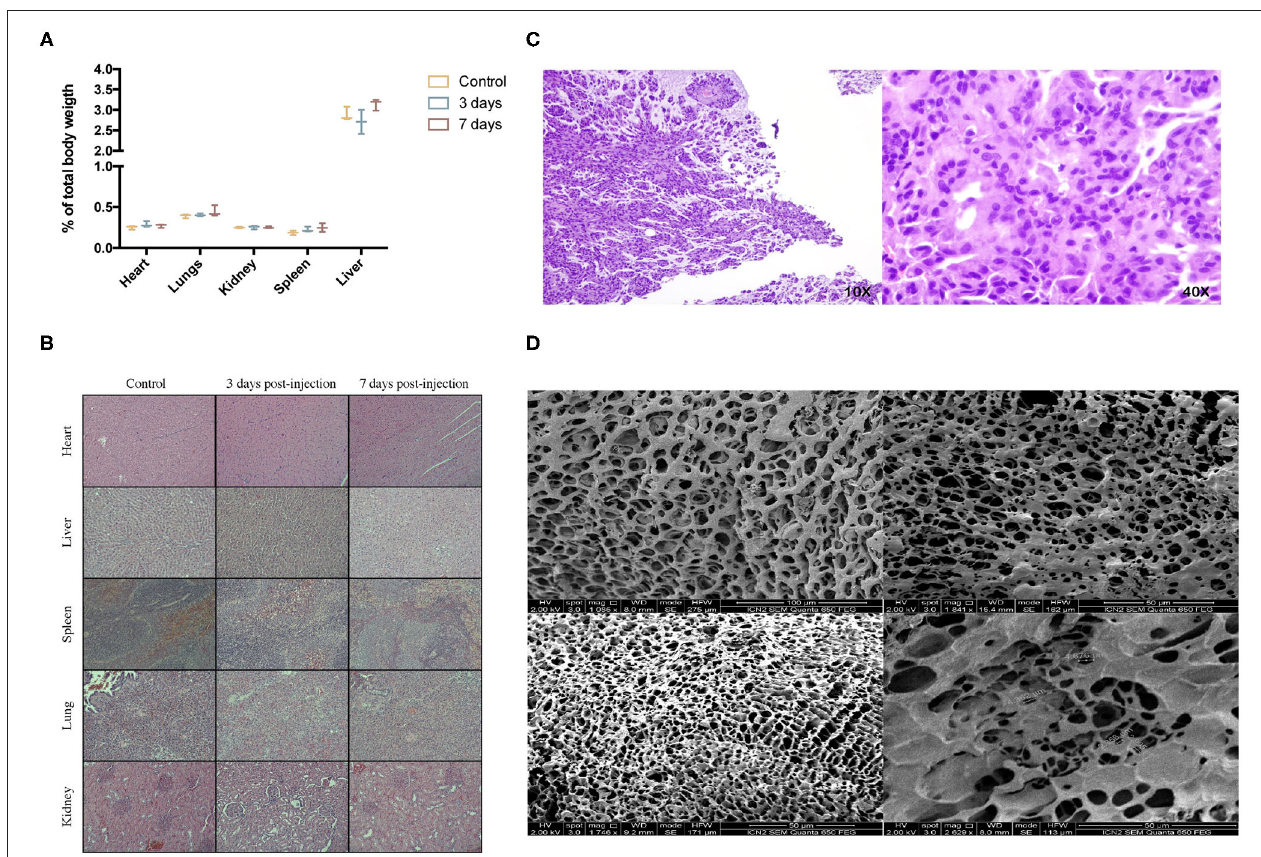
FIGURE 4 | In vivo biocompatibility study. (A) % of organ weight relative to total body weight after intraperitoneal injection of 10 mL/kg of CoverGel on rats. represents control rats rats euthanized 3 days post injection and rats euthanized 7 days post injection. (B) Representative images of major organs H/E stainings from each group at a 40 × zoom. (C) H/E staining images of tissue surrounding subcutaneously placed CoverGel after 10 days post placement (10 × left image, 40 × right image). (D) Scanning electron microscopy images of hydrogel after 10 days post subcutaneous